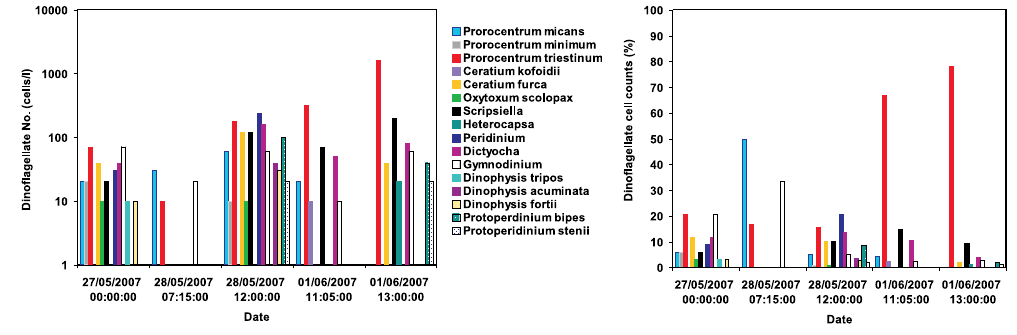
Fig. 5. Total and normalized cell counts for the dinoflagellate population in the oceanic seawater samples collected during the RHaMBLe cruise (color legend is in the same order as plot bars). Results indicated that Prorocentrum species were dominant in the dinoflagellate